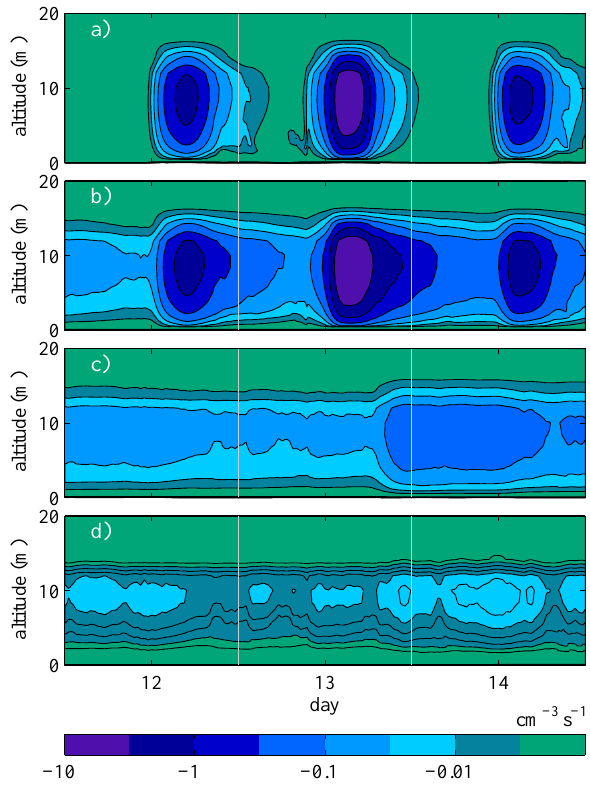
Fig. 8. Removal rate (cm − 3 s − 1 ) due to deposition for (a) 3–6nm (b) 3–25nm, (c) 25–100nm and (d) 100–1000nm particles. Re- moval rate is calculated as given by Eq.